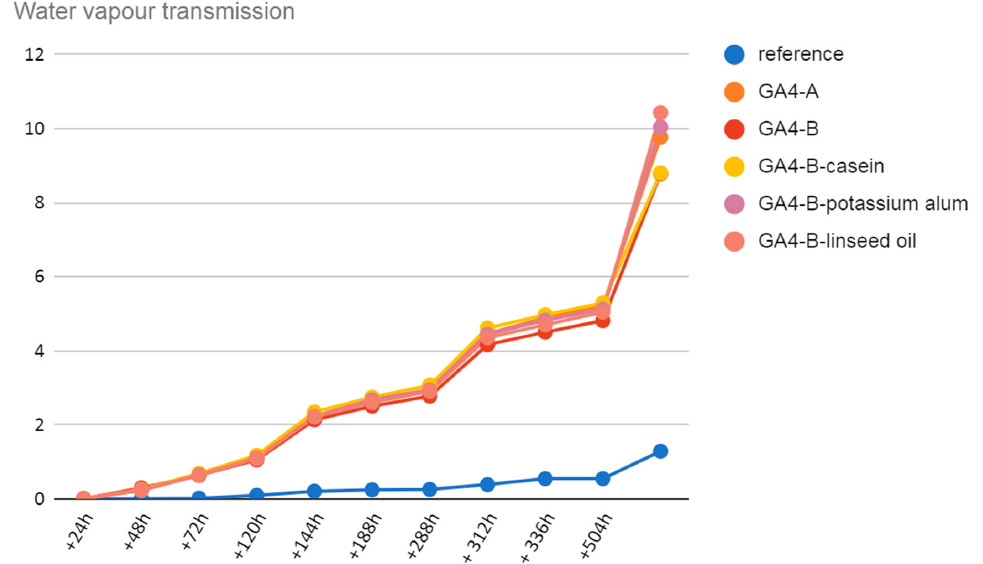
Figure 22. Results of water vapour transmission test.